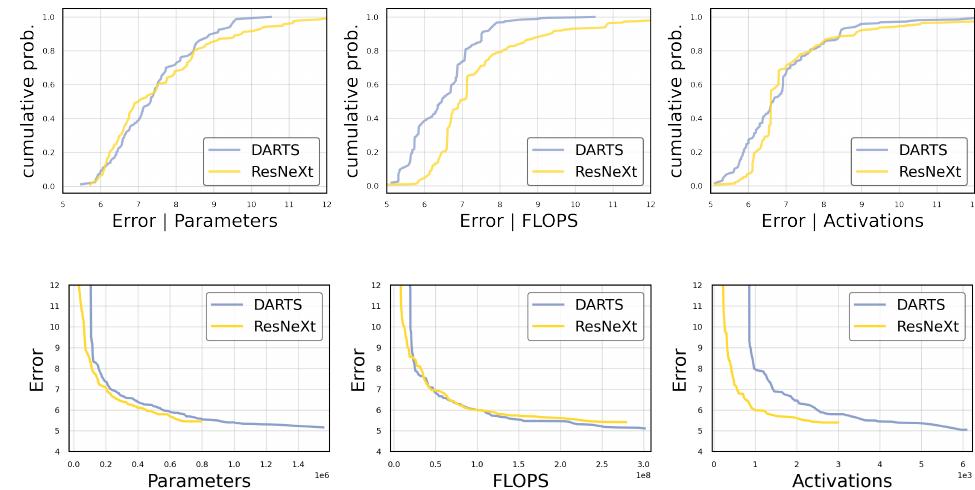
Figure 3. ( top ) The normalized error EDFs highlight that DARTS models produce more highly accurate models. ( bottom ) Random sampling accuracy/complexity curves show that, in the low complexity domain, ResNeXt outperforms